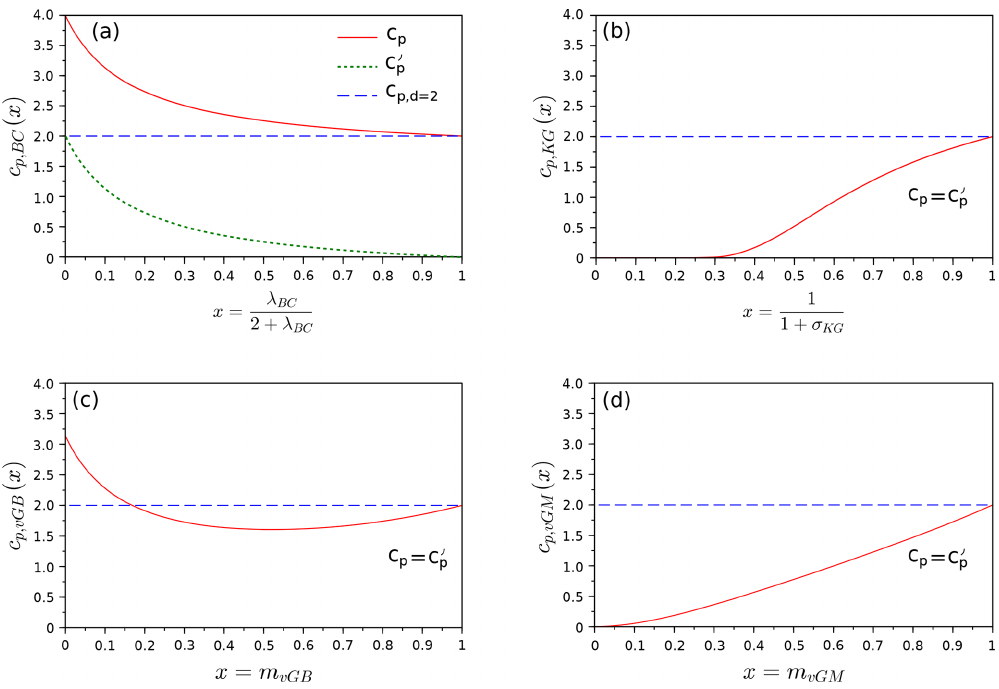
Figure 3. Square scaled sorptivity, c p , as a function of shape index, x , for the four hydraulic models, (a) Brooks and Corey (BC), (b) Ko- sugi (KG), (c) van Genuchten–Burdine (vGB), and (d) van Genuchten–Mualem (vGM); the models were sorted as a function of their monotonic features, with monotonically increasing functions on the